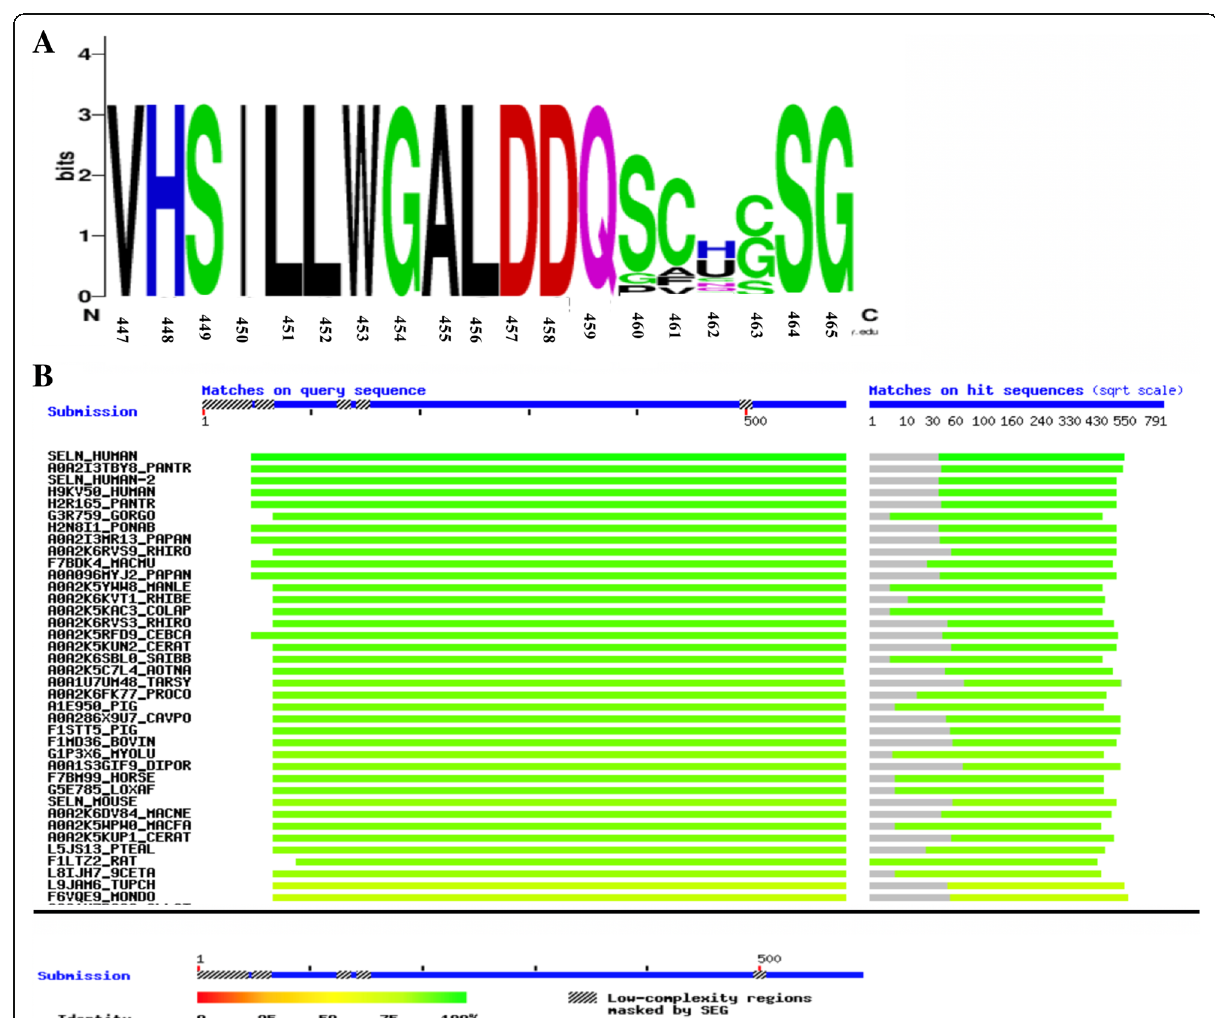
Fig. 3 a : Graphical representation of amino acid multiple sequence alignment among different species. It shows degree of conservation for amino acids 447 – 465 of SEPN1 protein. Position 460 (serine) indicates the mutated residue in our study. It has middle conservation degree (2 bits) and also shows that it is replaced by two other amino acids, i.e., glycine and proline in other species but not by phenylalanine. A logo represents the height of each letter proportional to the observed frequency of the corresponding amino acid. The overall height of each stack is proportional to the sequence conservation, measured in bits, at that position. The maximum sequence conservation per site is log 2 20 ≈ 4.32 bits for proteins. The protein sequence alignment was performed for the following species: Homo sapiens (Q9NZV5), Gorilla gorilla gorilla (G3R759), Pongo abelii (H2N8I1), Papio anubis (A0A2I3MR13), Rhinopithecus roxellan (A0A2K6RVS9), Sus scrofa (A1E950), Bos taurus (F1MD36), Myotis lucifugus (G1P3X6), Dipodomys ordii (A0A1S3GIF9), Equus caballus (F7BM99), Loxodonta africana (G5E785), and Mus musculus (D3Z2R5). b : Multiple protein sequence alignment of SEPN1 across different